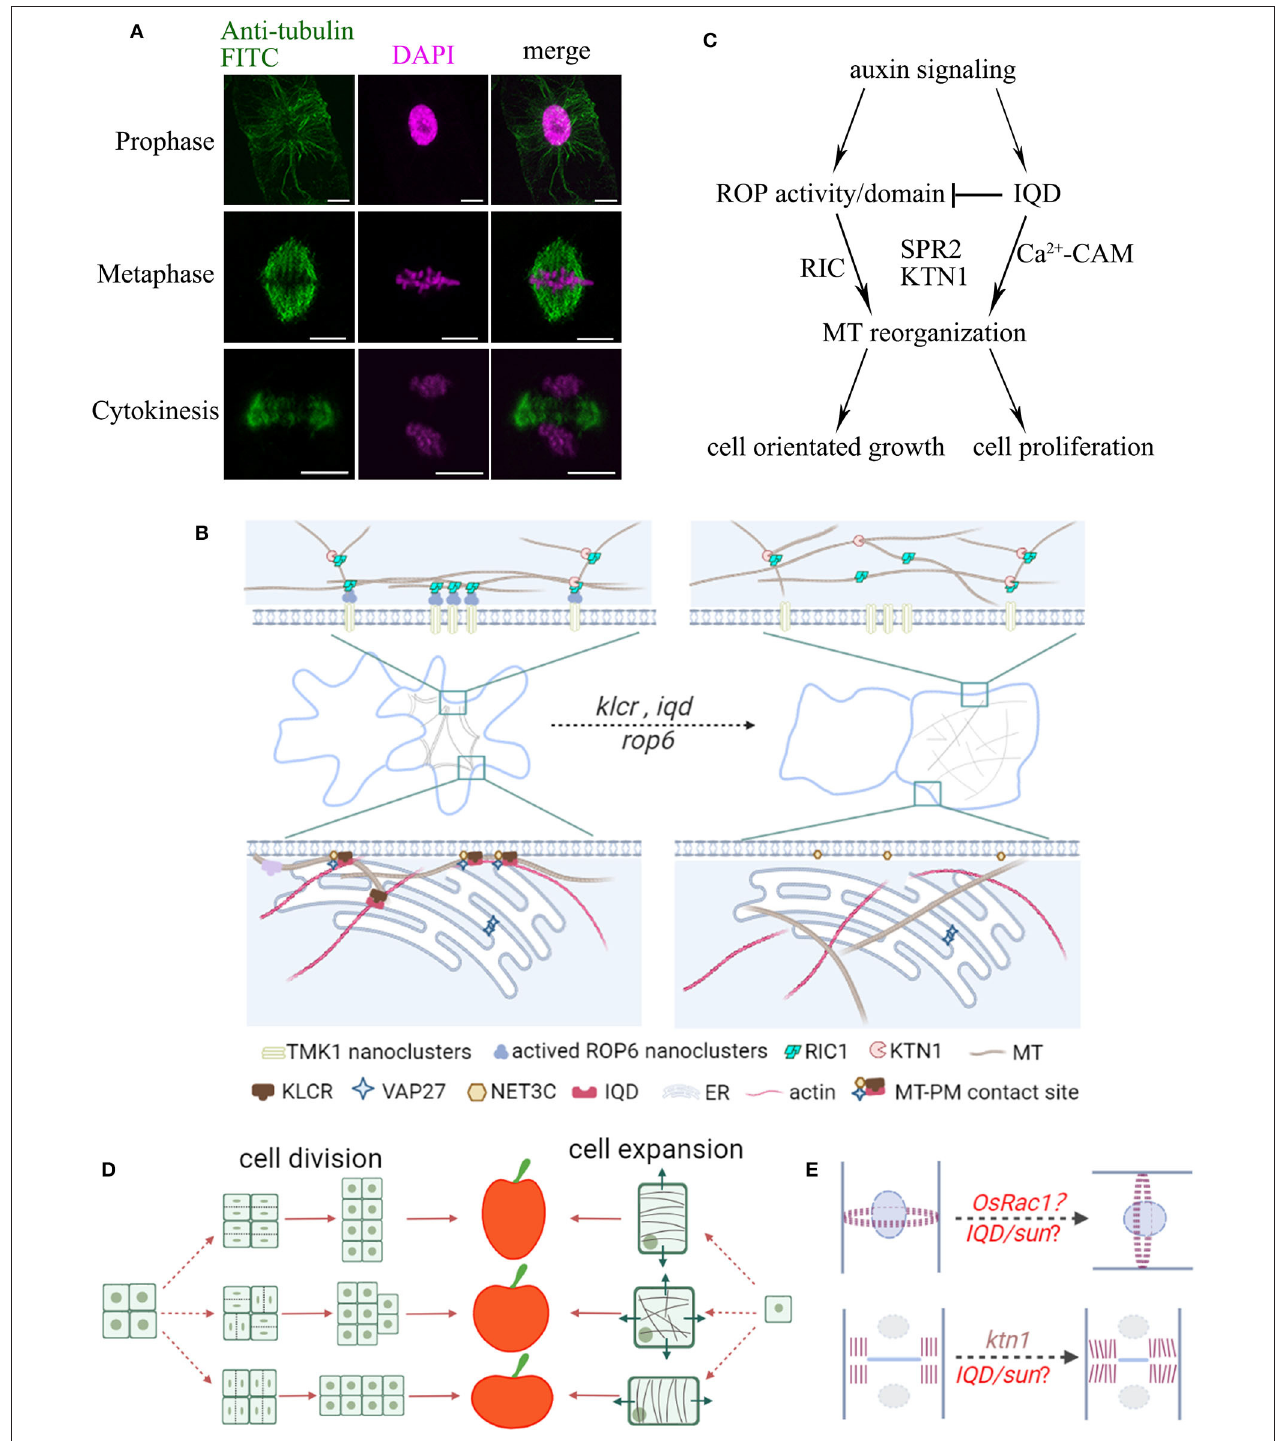
FIGURE 1 | Schematic summary of the organization of plant organ shape regulated by microtubules. (A) Localization of microtubules during cell division. BY-2 cells were immuno-labeled with anti-tubulin (microtubules, green) and DAPI (magenta, DNA). Microtubules rearrange throughout prophase, metaphase, and telophase to form the preprophase band (PPB), spindle apparatus, and phragmoplast, respectively. Bars, 10 µ m. (B) Leaf pavement cells display a typical jigsaw puzzle-shape appearance. During lobe formation, cortical microtubules are enriched at convex neck regions. MT-PM contact sites may take part in reorganization of microtubule arrays through IQDs-KLCR and ROP6-RIC1 proteins, whose mutants show more circular pavement cells and disorganized cytoskeletal networks. (C) Model of ROP and IQD pathways and their (proposed) role in regulating cell growth and division. Auxin signals activate ROPs, and recruit RIC1, KTN1 or other MAPs to promote microtubule ordering. On the other hand, auxin signals also activate IQDs, which regulate the distribution of ROPs on the PM and the organization of microtubules,